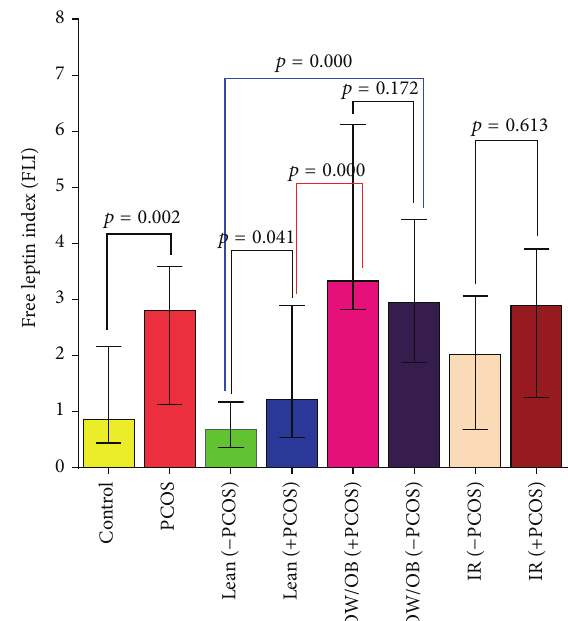
Figure 1: Free leptin index levels among the study subjects based on the presence of PCOS, OW/OB, and insulin resistance. Data are presented by median and interquartile (IQ) values (25%–75%). Data were analyzed by nonparametric Mann-Whitney test. 𝑝 values are shown between different groups. Two-tailed 𝑝 -value is significant at ≤